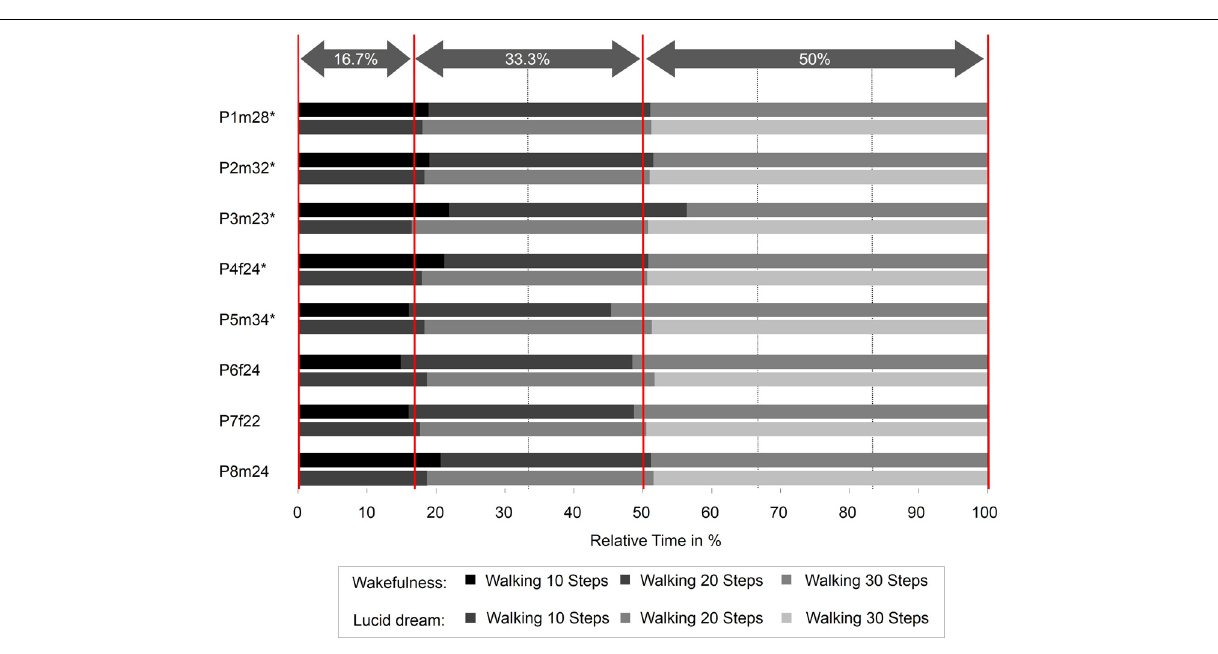
FIGURE 6 | Relative durations for the counting task during wakefulness and lucid dreaming (Labels: e.g., P1m28 = Participant 1, male, 28 years. ∗ Participants of the counting task also completed the walking